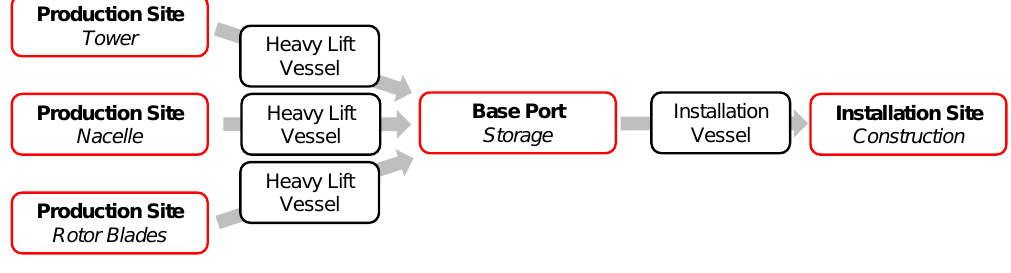
The conventional installation process for top structures of offshore wind farms (following